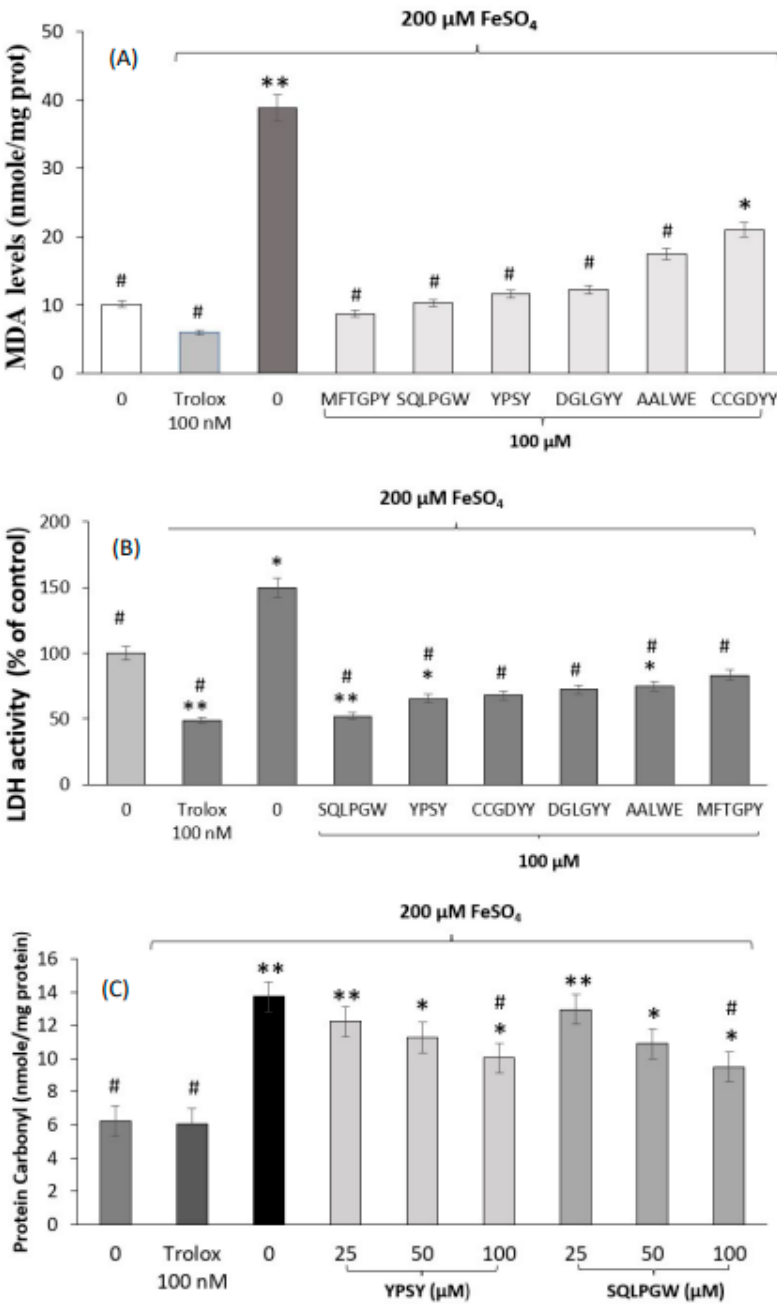
Figure 2. ( A ) MDA levels (nmol/mg protein) after the treatment of SH-SY5Y cells with FeSO 4 in the absence and presence of 100 µ M of pajuro peptides; ( B ) LDH activity (% of control) after the treatment of SH-SY5Y cells with FeSO 4 in the absence and presence of 100 µ M of pajuro peptides; ( C ) protein carbonyls levels (nmol/mg protein) after the treatment of SHSY5Y cells with FeSO 4 in the absence and presence of YPSP and SQLPGW different concentrations (25, 50, and 100 uM). * p < 0.05 or ** p < 0.001 vs. control (non-treated cells), # p < 0.001 vs. FeSO 4 treated